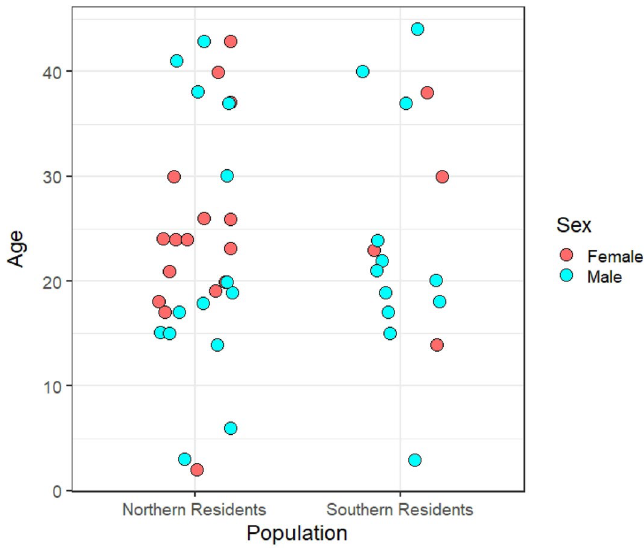
Figure 4. The distribution of age and sex of individuals in each population used in this